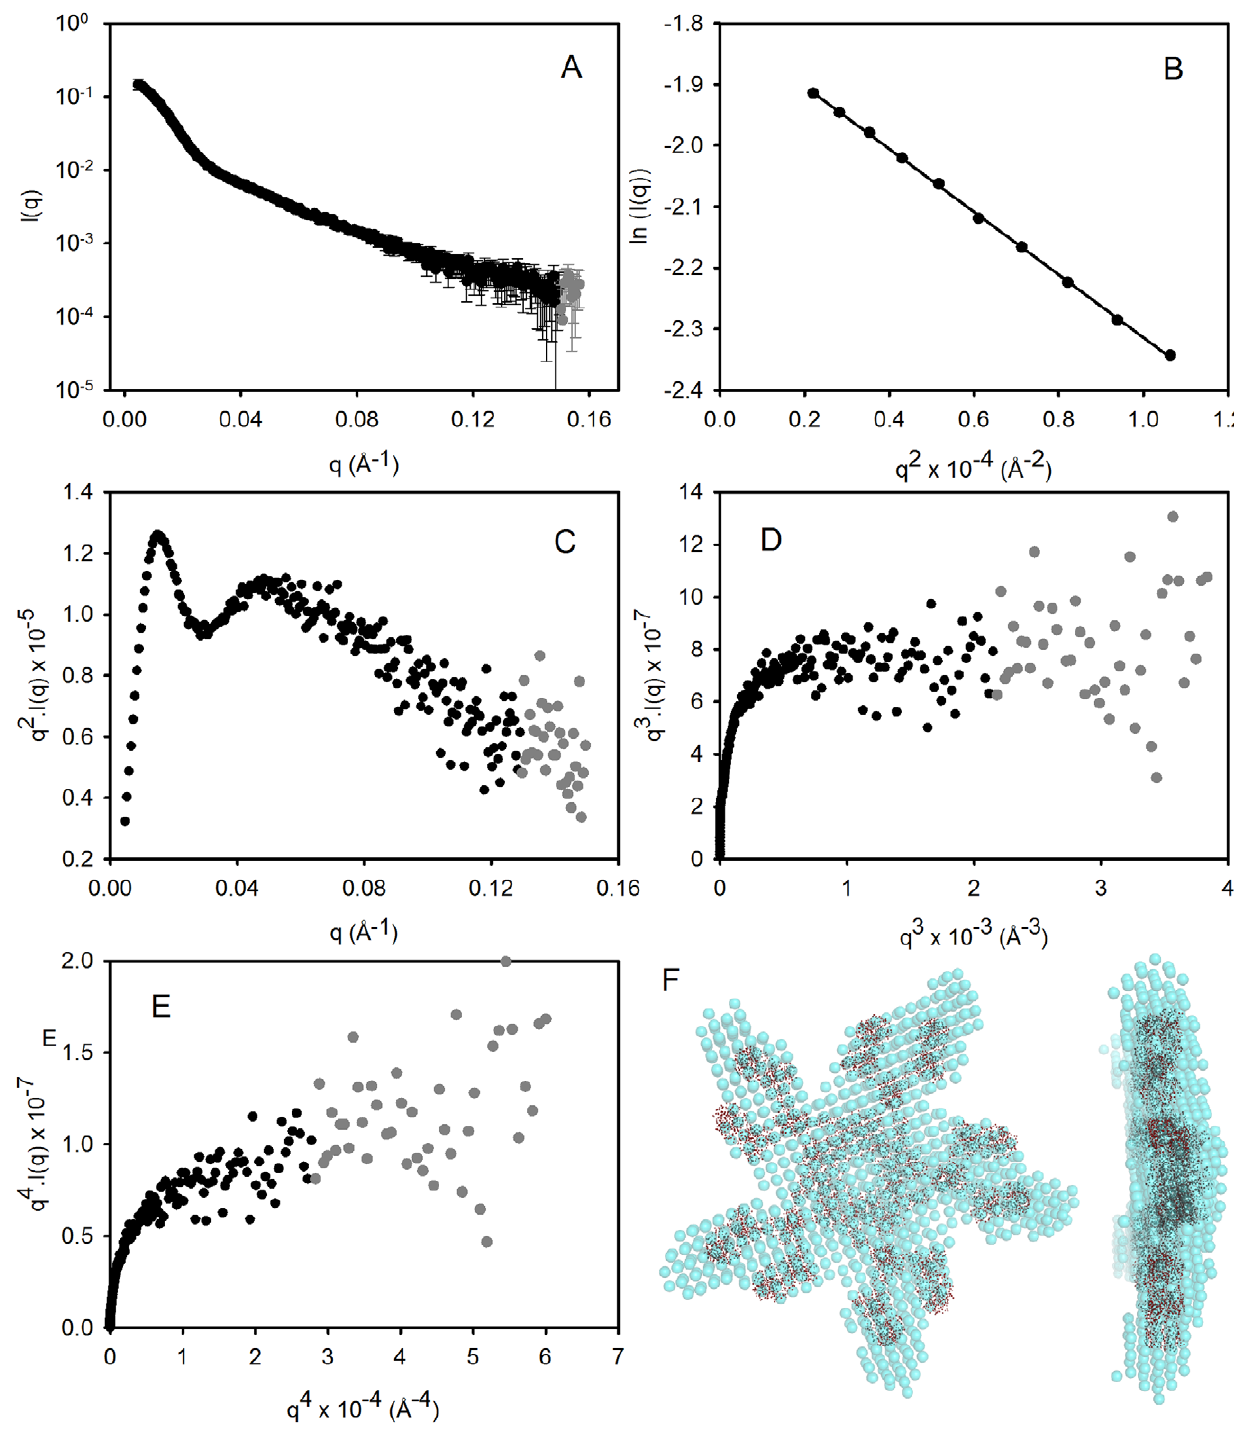
Figure 4. SAXS analysis of PAT-SM6. (A) The raw SAXS data are shown as circles representing mean intensity I ( q ) as a function of momentum transfer q . Error bars indicate 6 1 standard deviation ( s ). Black symbols: I ( q ) $ s and grey symbols: I ( q ) , s . (B) Guinier plot for these SAXS data for q . R g , 1.3. (C) Kratky plot of the SAXS data. (D & E) Porod-Debye plots as a function of q 3 and q 4 , respectively. (F) The ab initio shape reconstruction (average filtered shape from 10 reconstructions with explicit P5 symmetry) is shown superimposed on the rigid body refined SAXS model, generated using Fab and Fc fragments joined by a flexible 8-residue poly-Gly linker. The orientation of the four constant Ig domains of each Fc fragments was modelled on the crystal structure of the IgE and the relative Fc orientation was constrained by distance constraints enforcing inter-chain disulphide bonds [33].